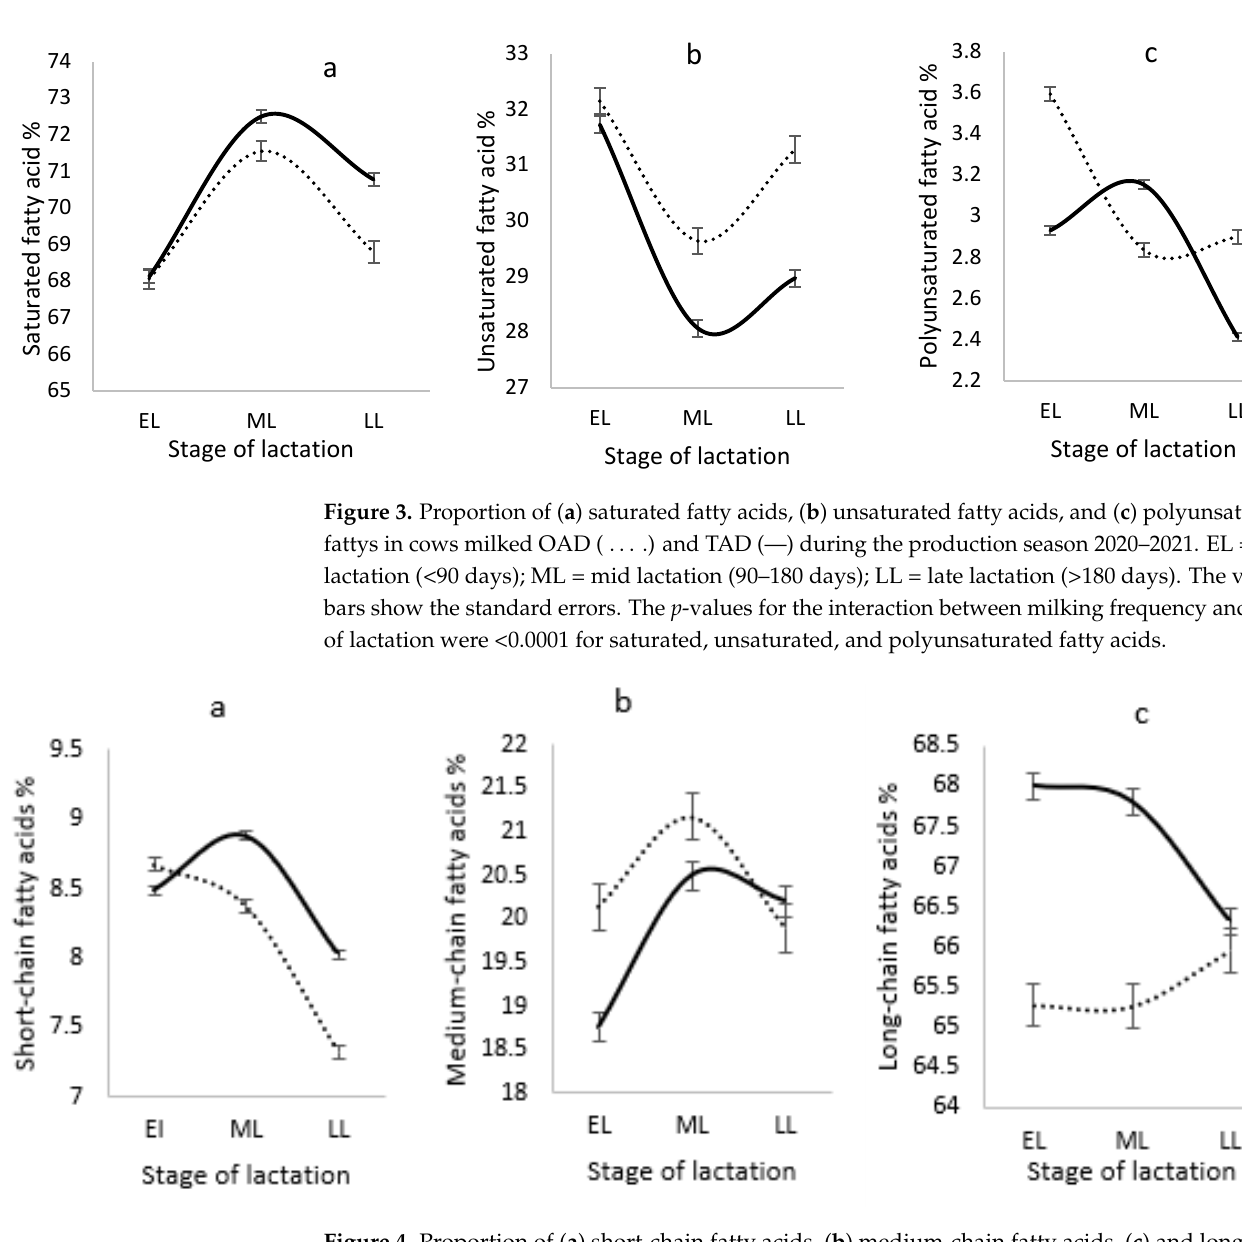
vertical bars show the standard errors. The p -values for the interaction between milking frequency fatty acids in cows milked OAD (….) and TAD (—) during the production season 2020–2021. EL = and stage of lactation were <0.0001 for short-chain, medium-chain, and long-chain fatty